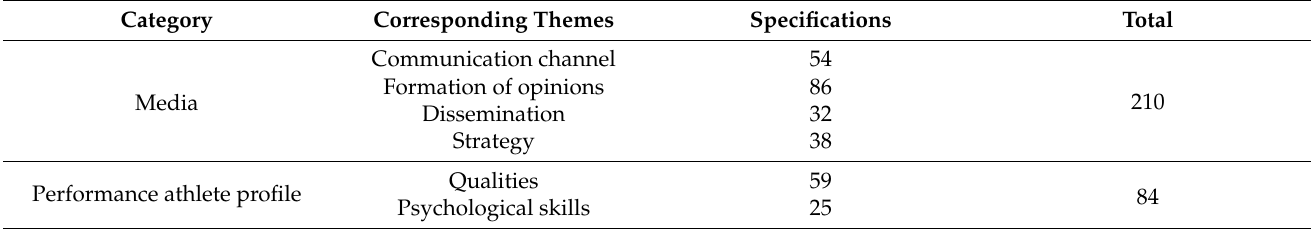
Table 7. Total number of specifications for “mass media” and “performance athlete